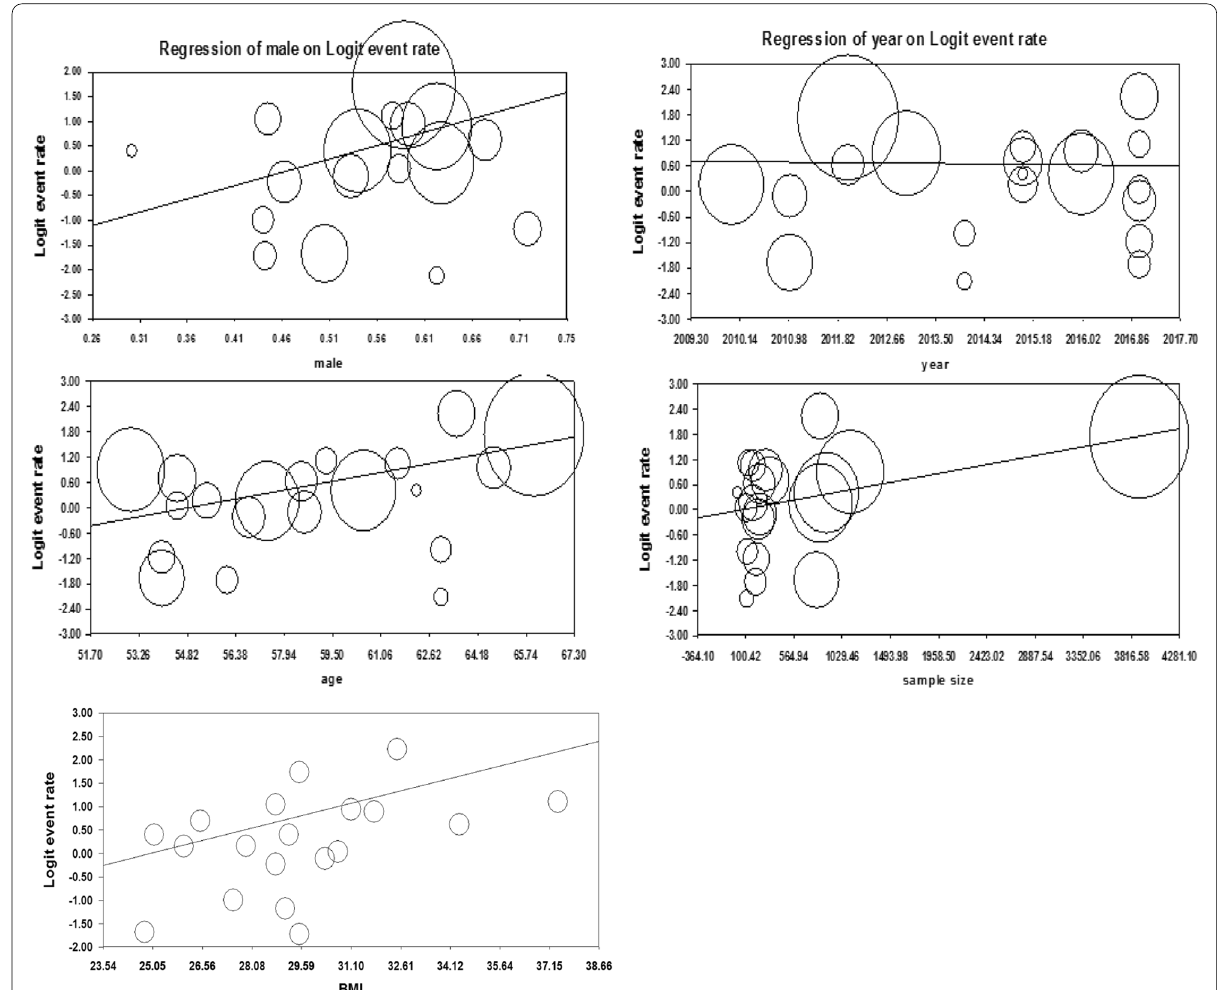
Fig. 4 Scatter plot for the relationship between OSA and Percent of men, year of stydy, age, BMI, and sample